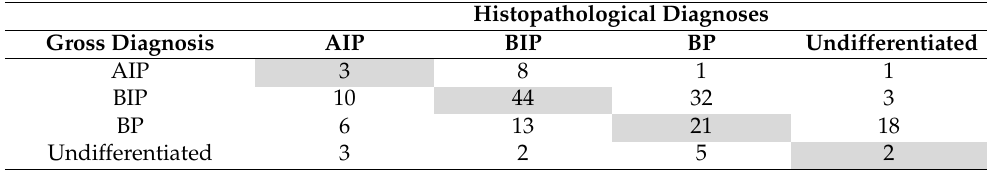
Table 3. Individual case classification based on HistoDx or GrossDx in cases ( n = 172) diagnosed with each methodology as either acute interstitial pneumonia (AIP), bronchopneumonia with interstitial pneumonia (BIP), bronchopneumonia (BP), or Undifferentiated (including healthy). Shaded cells represent cases where HistoDx and GrossDx showed agreement.